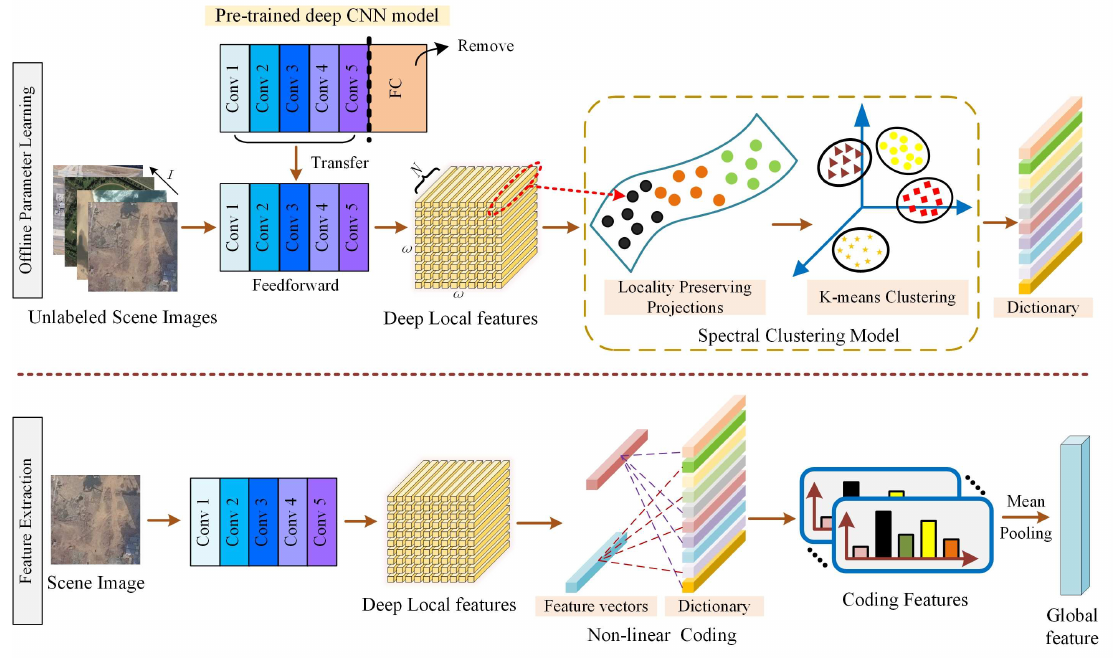
Figure 4. The procedures of deep local feature extraction and improved bag-of-view-word ( i BoVW)